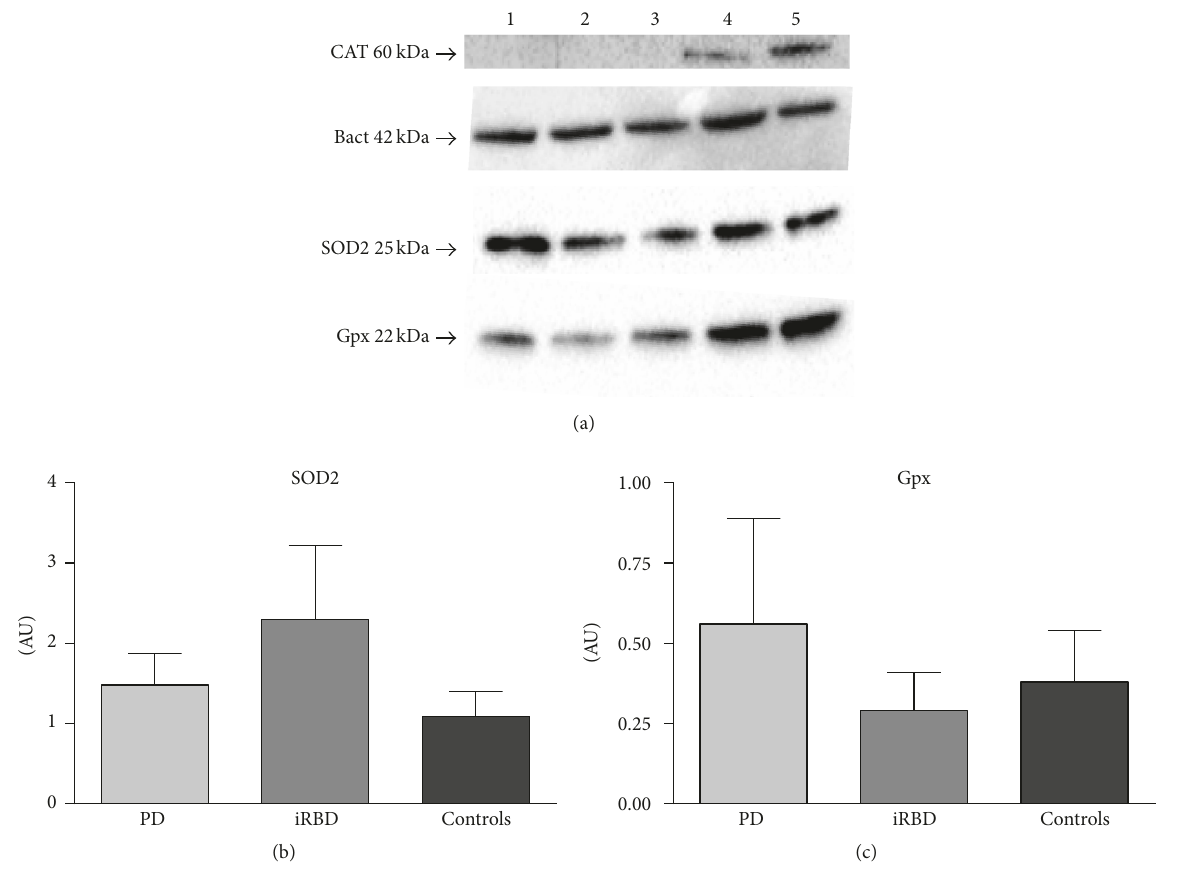
Figure 2: Antioxidant enzymes quantification through western analysis of controls ( 𝑛 = 9 ), iRBD ( 𝑛 = 7 ), and PD patients ( 𝑛 = 9 ). (a) Representative blots showing expression levels CAT, SOD2 and Gpx antioxidants, and 𝛽 -actin loading control. Well ID is as follows: (1) control, (2) control, (3) iRBD, (4) iRBD, and (5) control. (b) Quantification of SOD2 levels. (c) Quantification of Gpx levels. AU, arbitrary units; SOD2, superoxide dismutase-2; Gpx, glutathione peroxidase; PD, Parkinson’s disease; iRBD, idiopathic REM sleep behavior